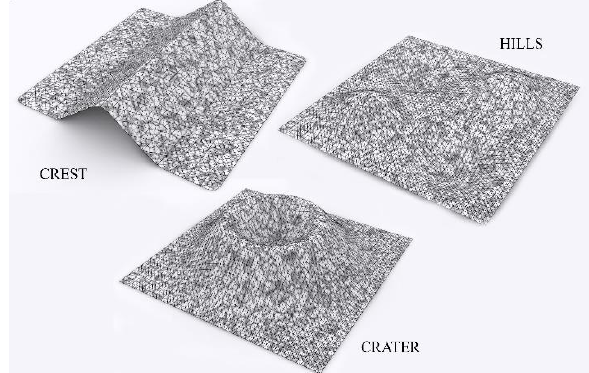
Figure 3: The 3D models of the simulated DTMs.